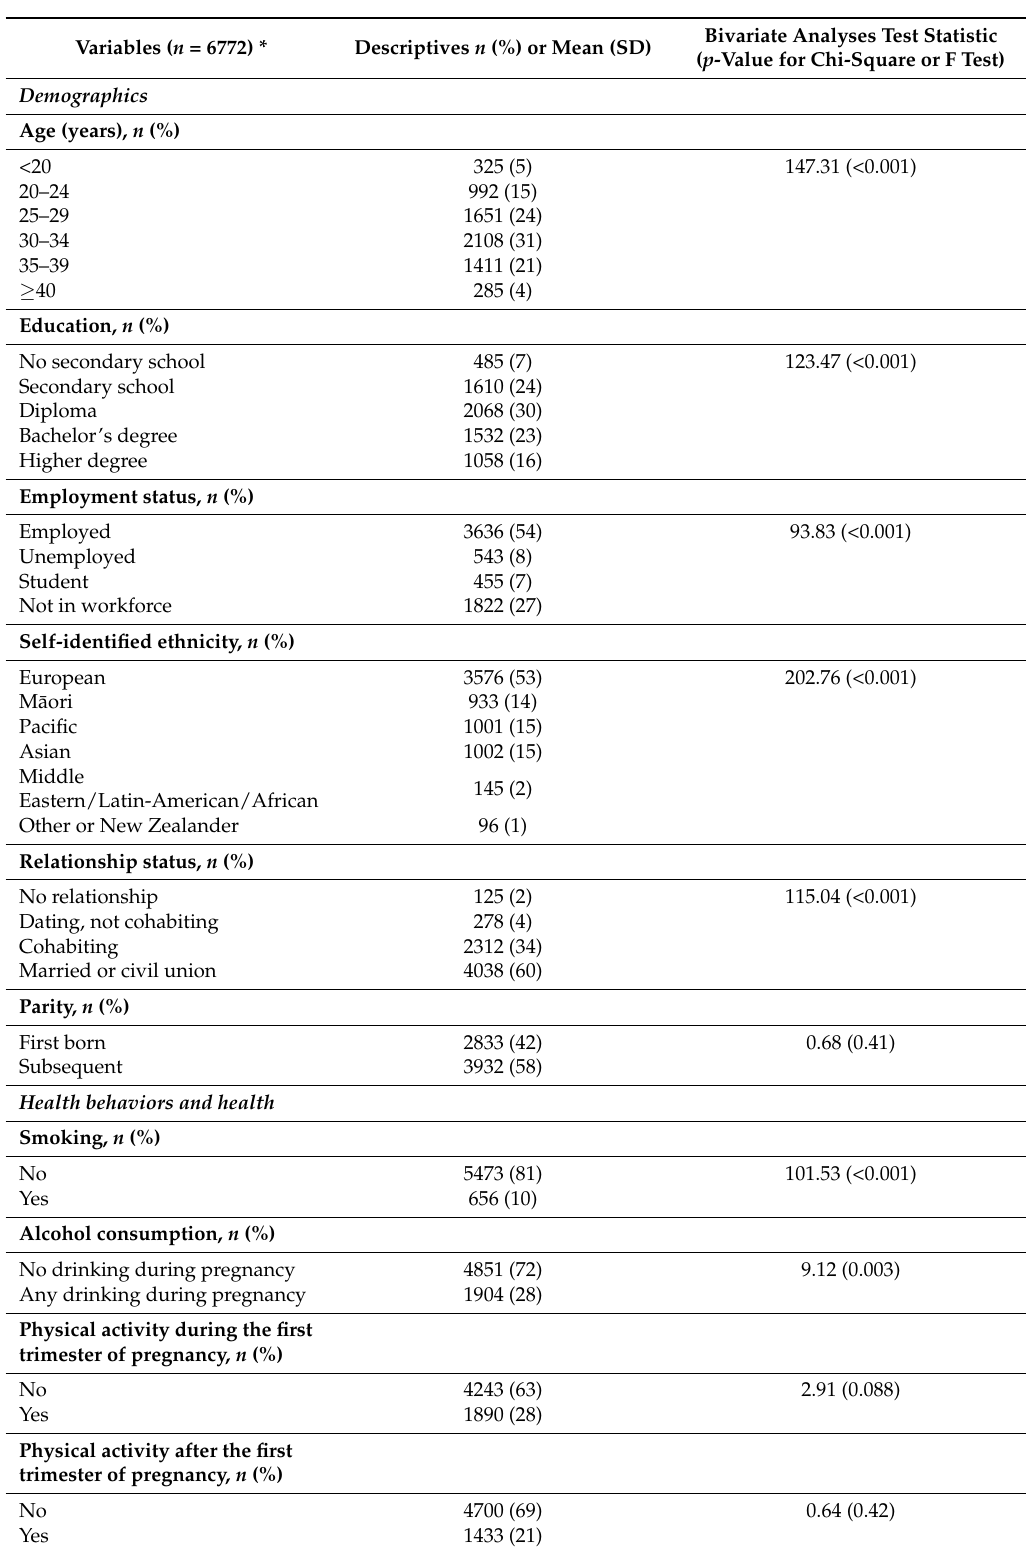
Table 1. Demographics and other characteristics of antenatal mothers and bivariate analyses for antenatal depression used to assess the effect of green space on antenatal depression from the Growing Up in New Zealand study